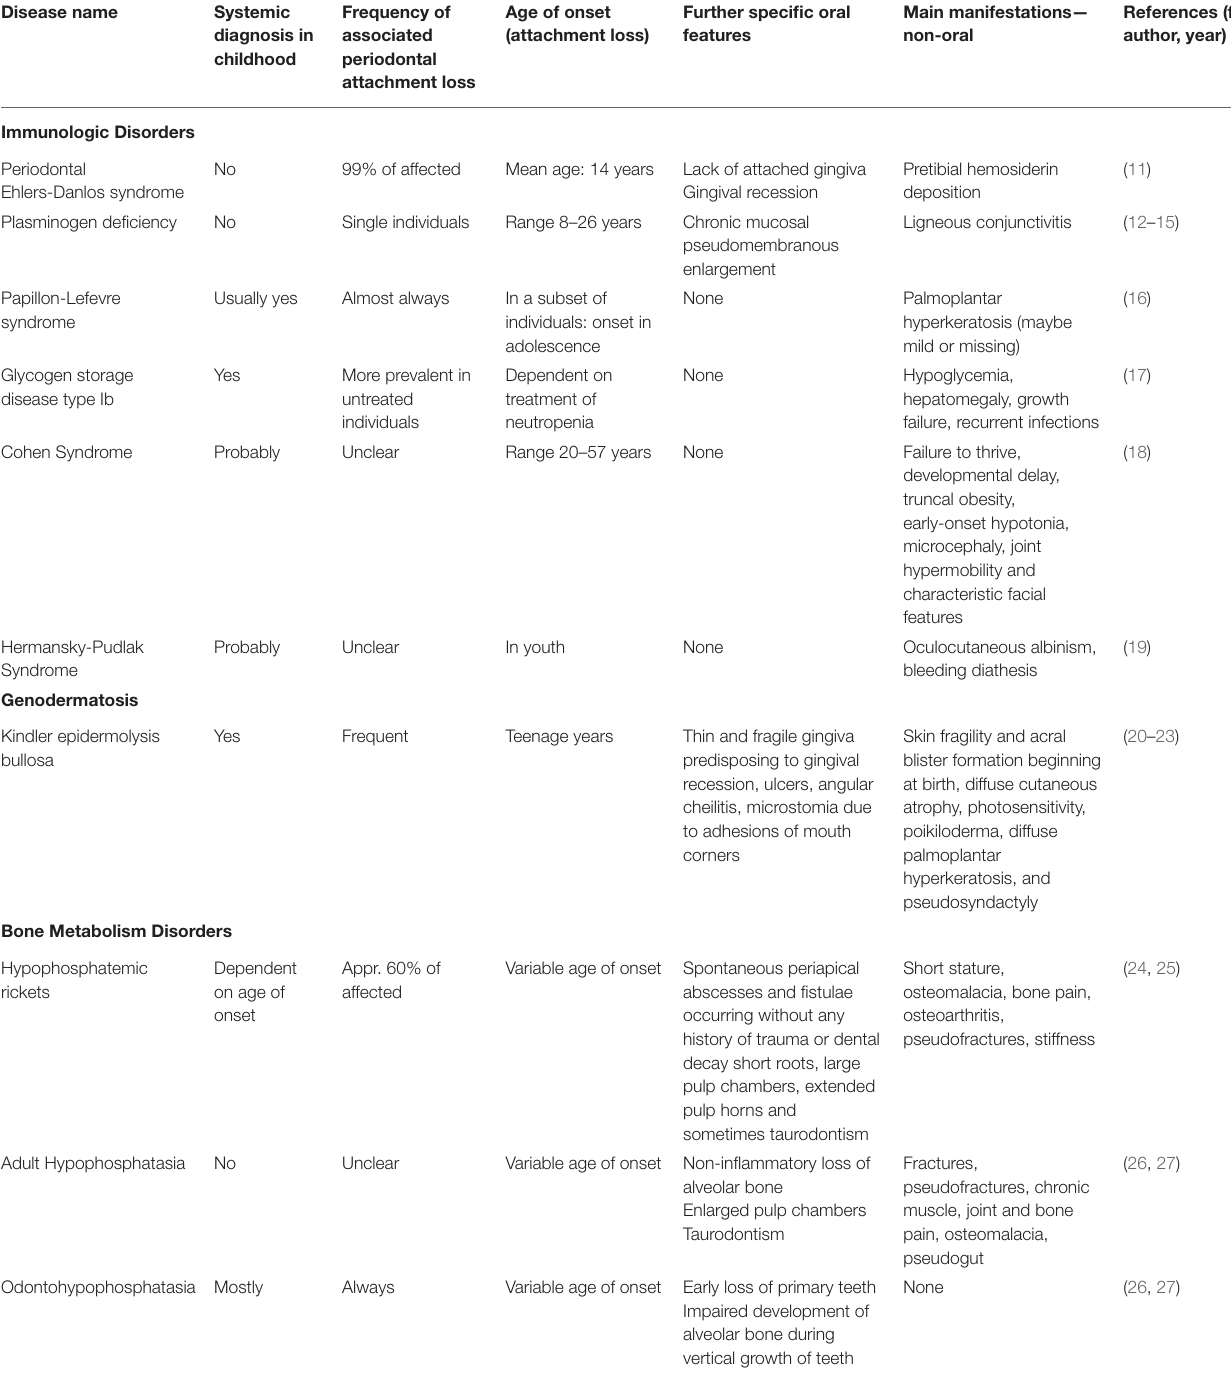
TABLE 1 | Periodontitis as manifestation of systemic diseases with primary onset in adolescence. Disease